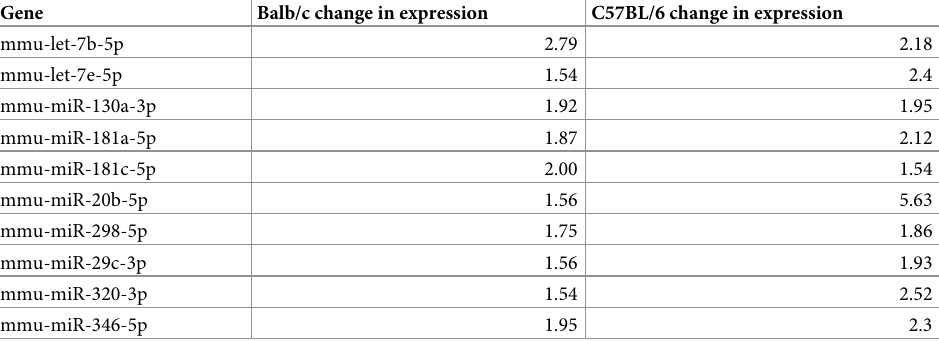
Table 2. miRNAs that are at least 1.5-fold different in mice that are fed B . longum versus those that are fed only media.